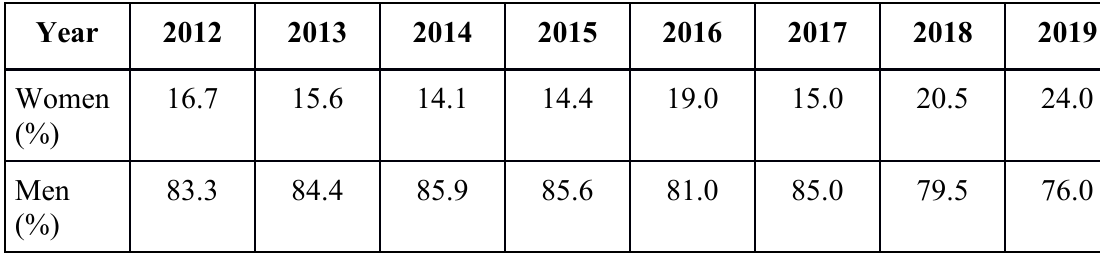
TABLE 5 . THE RATIO OF WOMEN AND MEN IN THE HIGHER EDUCATION SYSTEM AT THE EXECUTIVE LEVEL IN